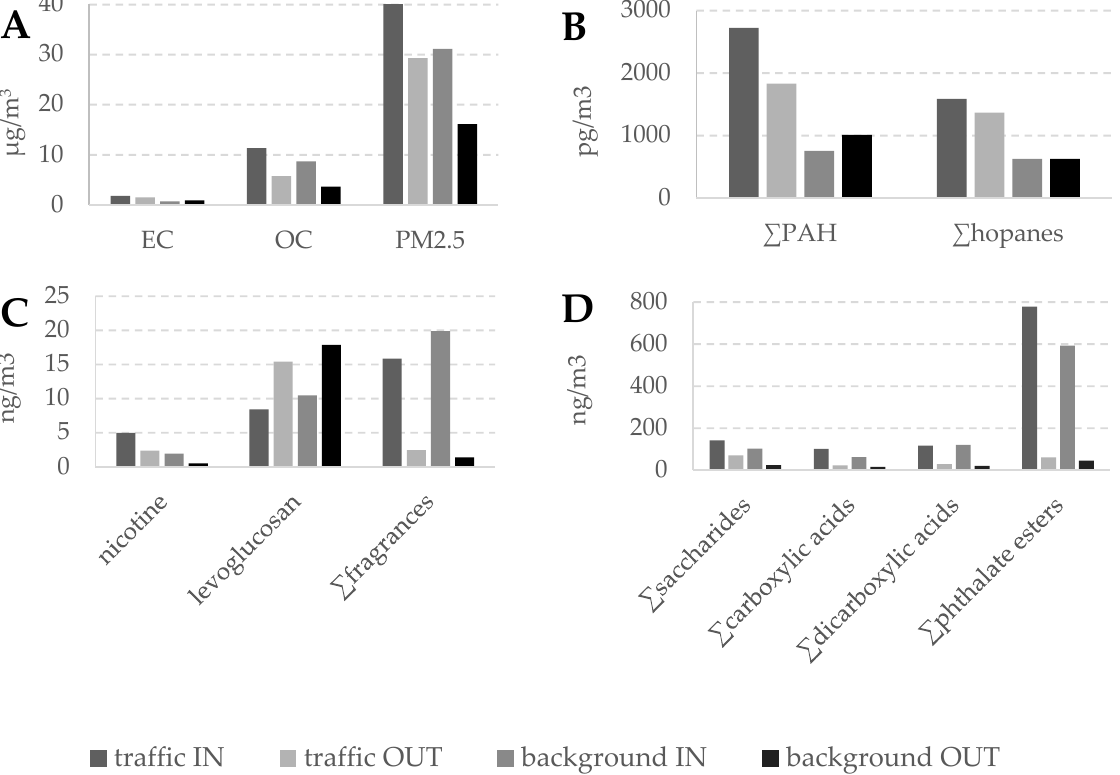
Figure 2. Mean concentrations of ( A ) elemental carbon (EC), organic carbon (OC), PM 2.5 , and the sum of organic molecular compounds ( B ): polycyclic aromatic hydrocarbon (PAH), hopanes, ( C ): nicotine, levoglucosan, fragrances, ( D ): saccharides, (di-)carboxylic acids, and phthalate esters) in the indoor and outdoor aerosols of the schools located near tra ffi c and background